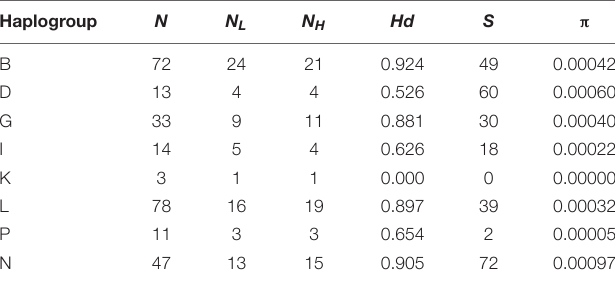
N = number of individuals; N L = number of lineages; N H = number of haplotypes; Hd = haplotype diversity; S = number of polymorphic sites; π = nucleotide diversity.